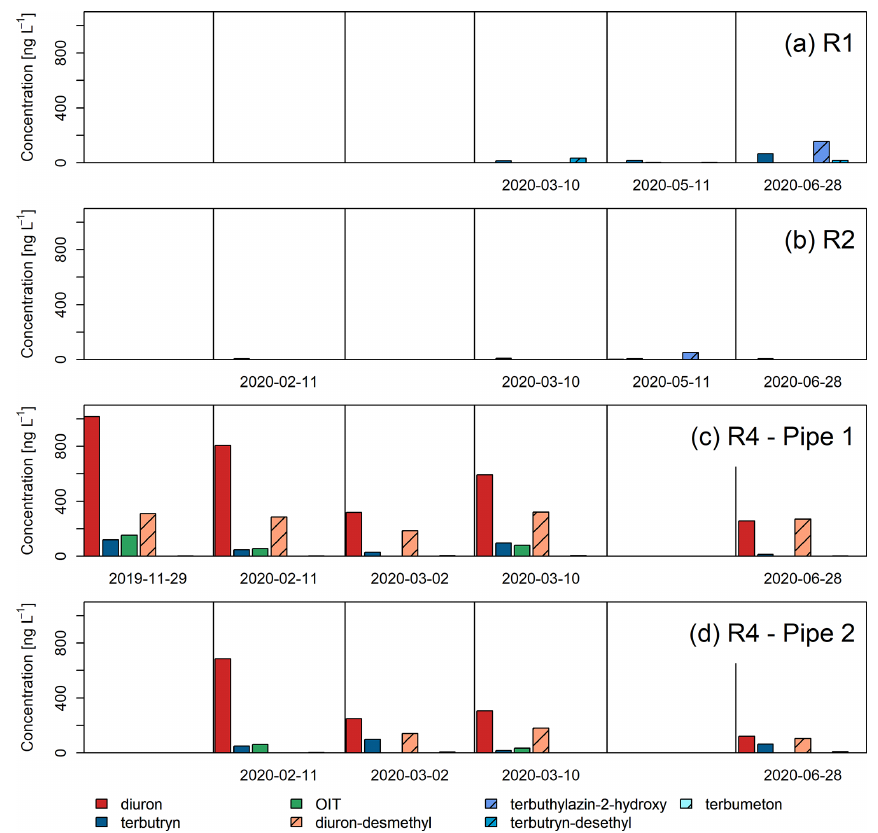
Figure 7. Sampled events in rainwater downpipes at three houses. The number after R refers to the number of the house. Non-sampled events are shown without a date.